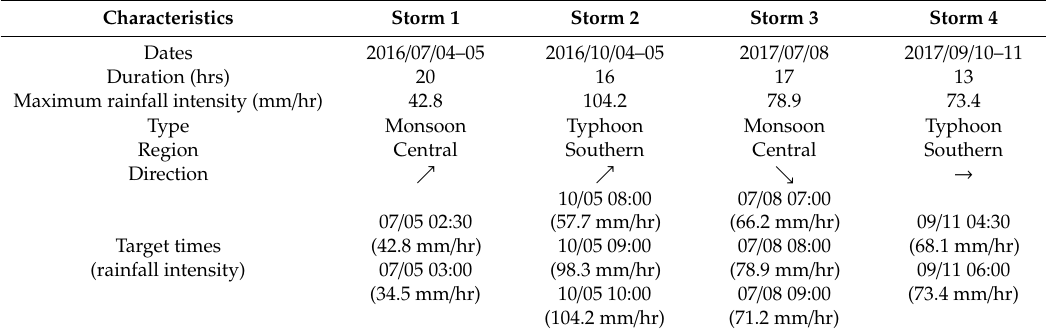
Table 1. Characteristics of the selected storm events in this study.